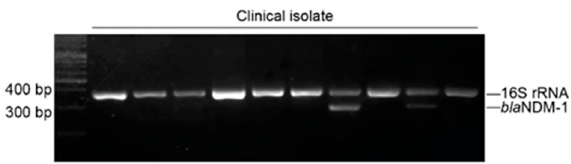
Figure 2. PCR products on agarose gel after the electrophoresis Figure 2 . PCR products on agarose gel after the electrophoresis process.